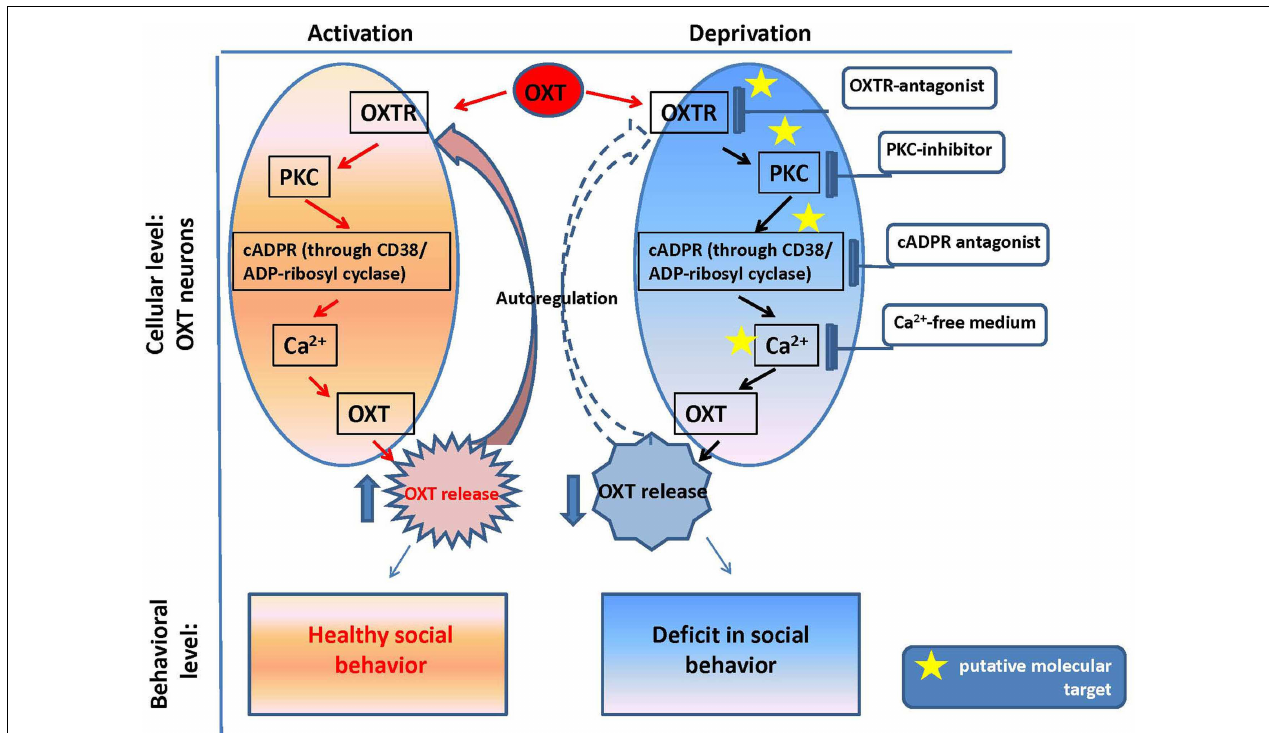
FIGURE 2 | Oxytocin positive feedback control and oxytocin signaling in psychophysiological